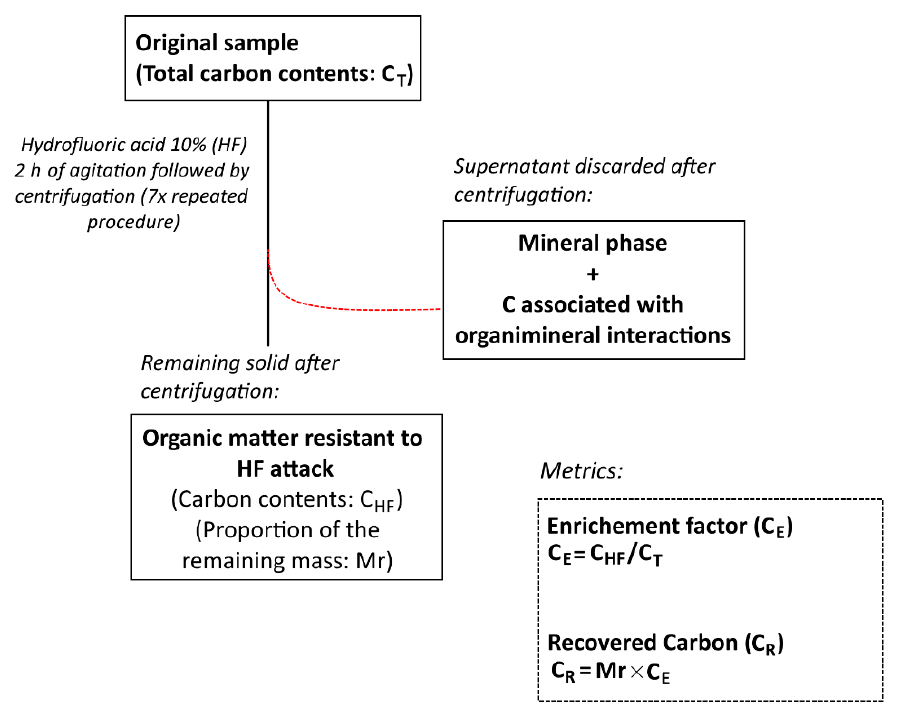
Figure 2. Schematic of the steps involved in the soil demineralization method. The framed texts denote the obtained fractions, unframed texts denote analytical procedures, and the dashed frames contain the used